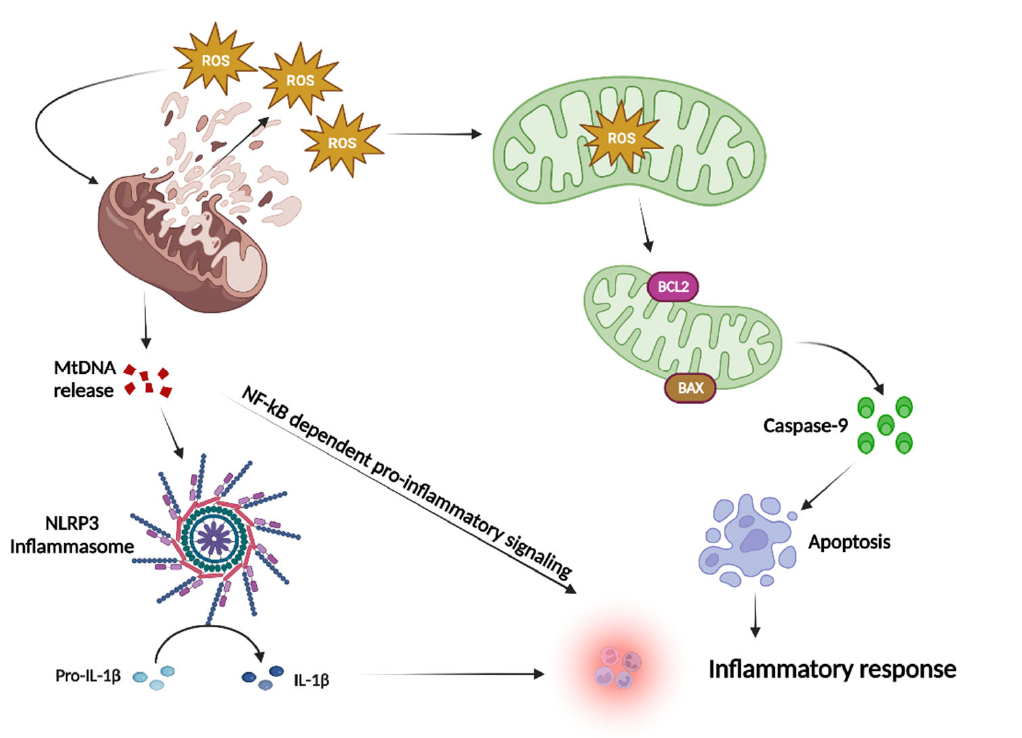
Figure 3. mtROS plays multiple roles in inflammatory responses.